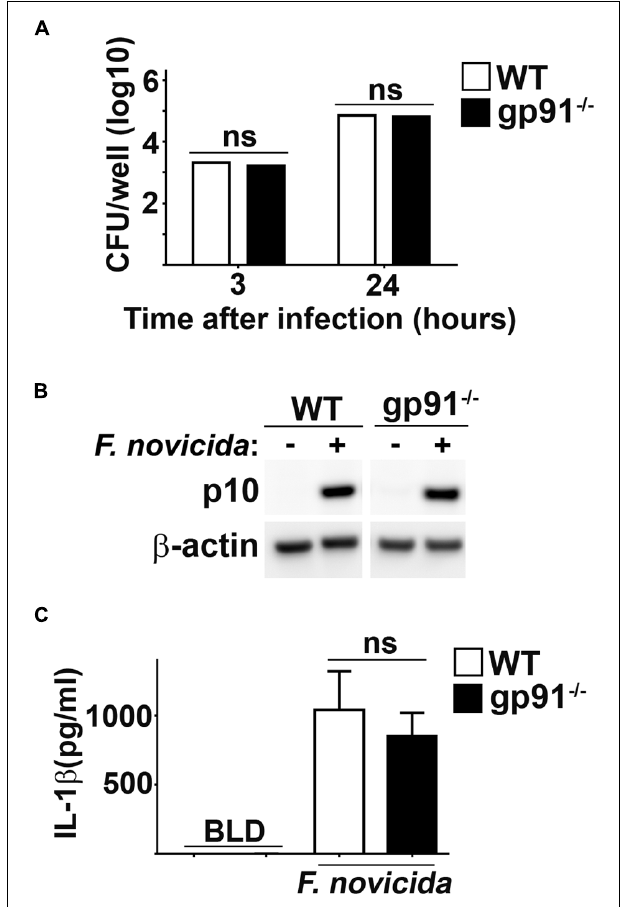
FIGURE 3 | Inhibition of ROS suppresses Fn driven inflammasome activation. As indicated, BMM were treated with NAC (3 mM), L -NMMA (1 mM) or water (vehicle control; mock) 16 or 24 h prior to infection with Fn MOI 250, respectively. (A) Intracellular bacteria were enumerated at the indicated times after infection. (B) Western blots of cell lysates were probed for caspase-1 p10 and actin. (C) Culture supernatants were assessed for IL-1 β by ELISA. Error bars depict SD. ns, no significant difference between mock and L -NMMA treated cells. * p < 0.05 compared to mock and L -NMMA treated cells. Data are representative of three experiments of similar design.